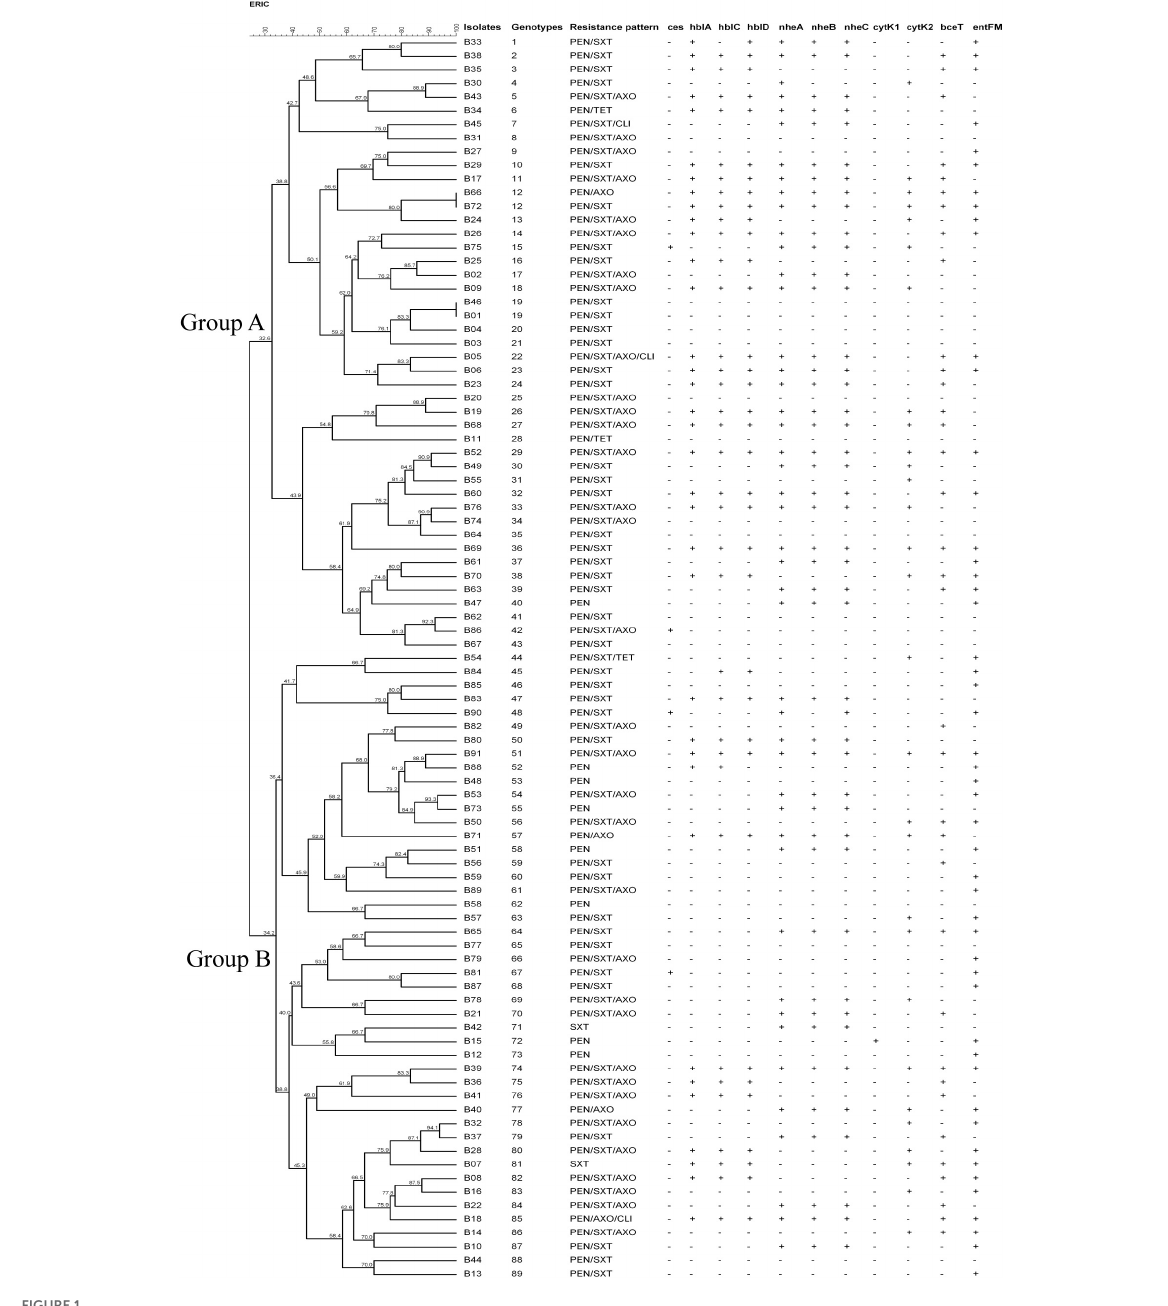
Prevalence of antimicrobial resistance The antimicrobial susceptibility profile of the B. cereus isolates is shown in Table 3 . Various susceptibility patterns against 12 types of antibiotics were exhibited. All isolates were susceptible to vancomycin, amikacin, imipenem,